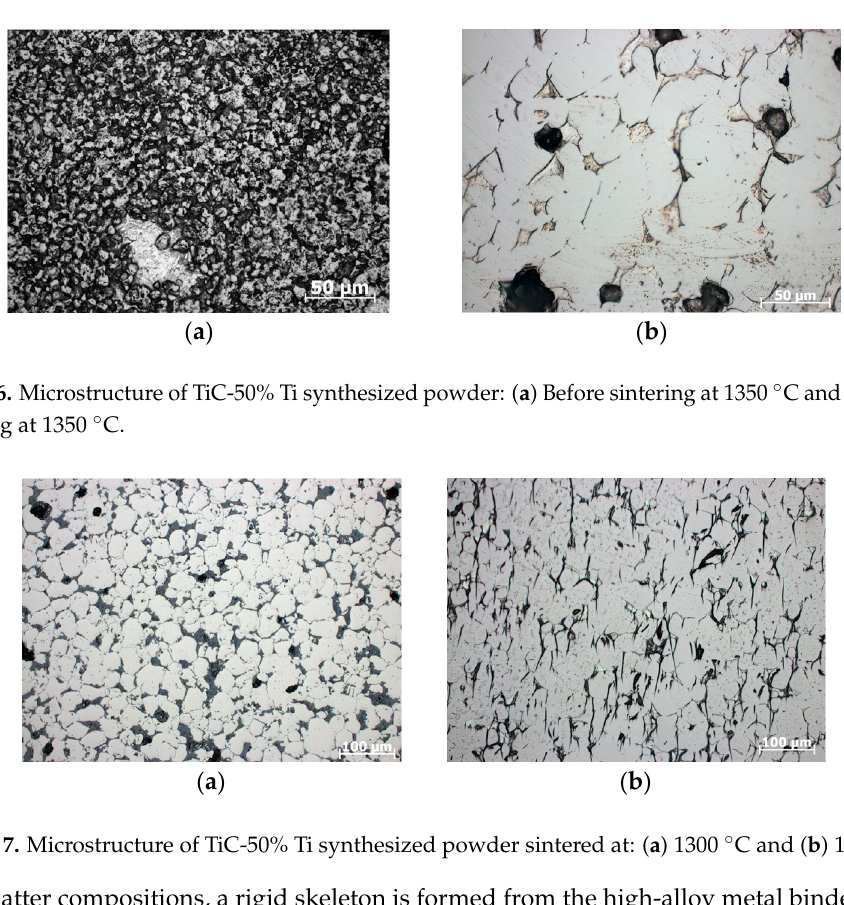
( d ) Figure 5. Sintered at 1300 °C: ( a ) microstructure of nickel-based self-fluxing alloy powder; ( b ) high- speed steel powder; ( c ) TiC-50% nickel-based self-fluxing alloy synthesized powder; and ( d ) TiC-50% high-speed steel synthesized powder. Although the powders of high-speed steel and nickel-based self-fluxing alloys themselves are well-sintered (Figure 5a,b), in the presence of the titanium carbide the "negative" redistribution of the carbon takes place towards the metallic binder. This is assisted by the presence of carbon-active components in the alloys of high-speed steel and nickel-based self-fluxing alloy: Tungsten and molybdenum in high-speed steel and chromium in the nickel-based s elf-fluxing alloy , where nickel can also have an active influence on the titanium bound in the carbide. It was found that the non-equilibrium metal-matrix structure of the powders formed as a result of SHS by the layerwise combustion method consisting mainly of non-stoichiometric titanium carbide [30,31]. Many works are devoted to the non-stoichiometricity of titanium carbide [6,8–10]. Unfortunately, there are not enough publications showing the influence of this factor on the various processes of structure formation. Our research shows that subsequent heat treatment in the mode of